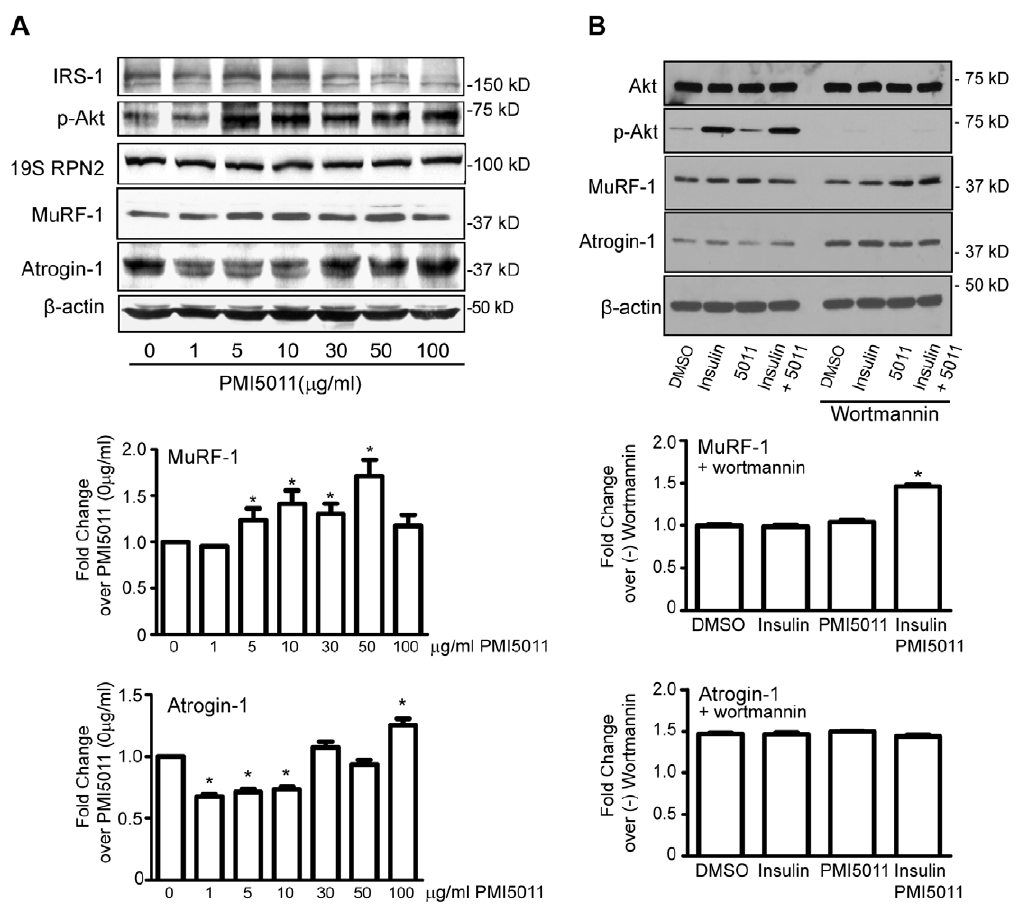
Figure 1. PMI5011 regulates expression of Atrogin-1 and MuRF-1 in skeletal muscle in a PI3K/Akt dependent manner. (A) C2C12 myotubes were incubated with the indicated concentrations of PMI5011 and whole cell extracts were harvested 16 hours thereafter. The levels of IRS-1, pAkt, 19S proteasome subunit RPN2, Atrogin-1 and MuRF-1 were assayed by western blot analysis. The fold change in Atrogin-1 and MuRF-1 expression was analyzed from three separate experiments. The fold change in Atrogin-1 and MuRF-1 protein expression compared to expression